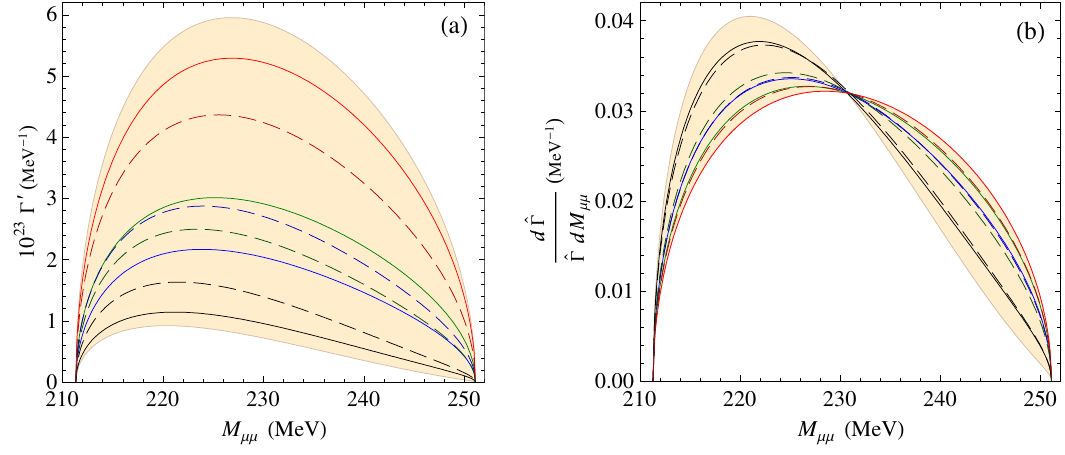
Figure 2 . (a) The dimuon invariant-mass distribution, (cid:0) 0 = d (cid:0)((cid:6) + ! p(cid:22) + (cid:22) (cid:0) ) =dq 2 versus p M (cid:22)(cid:22) = q 2 , calculated in the SM with Im( a; b; c; d ) formulas derived in relativistic (solid curves) or heavy-baryon (dashed curves) (cid:31) PT. From bottom to top, the black, blue, green, and red solid [dashed] curves correspond to Re( a; b ) = MeV = (13 : 3 ; (cid:0) 6 : 0) ; ( (cid:0) 13 : 3 ; 6 : 0) ; (6 : 0 ; (cid:0) 13 : 3) ; ( (cid:0) 6 : 0 ; 13 : 3) [(11 : 0 ; (cid:0) 7 : 4) ; ( (cid:0) 11 : 0 ; 7 : 4), (7 : 4 ; (cid:0) 11 : 0) ; ( (cid:0) 7 : 4 ; 11 : 0)], respectively. The light-orange (shaded) re- gion enveloping the curves corresponds to the parameter space represented by the benchmark (cid:0) (cid:1) points in (cid:12)gure 1. (b) The related di(cid:11)erential rate d ^ (cid:0) =dM (cid:22)(cid:22) = ^ (cid:0) = 2(cid:0) 0 M (cid:22)(cid:22) = ^ (cid:0) normalized by ^(cid:0) = (cid:0)((cid:6) + ! p(cid:22) + (cid:22) (cid:0) ).